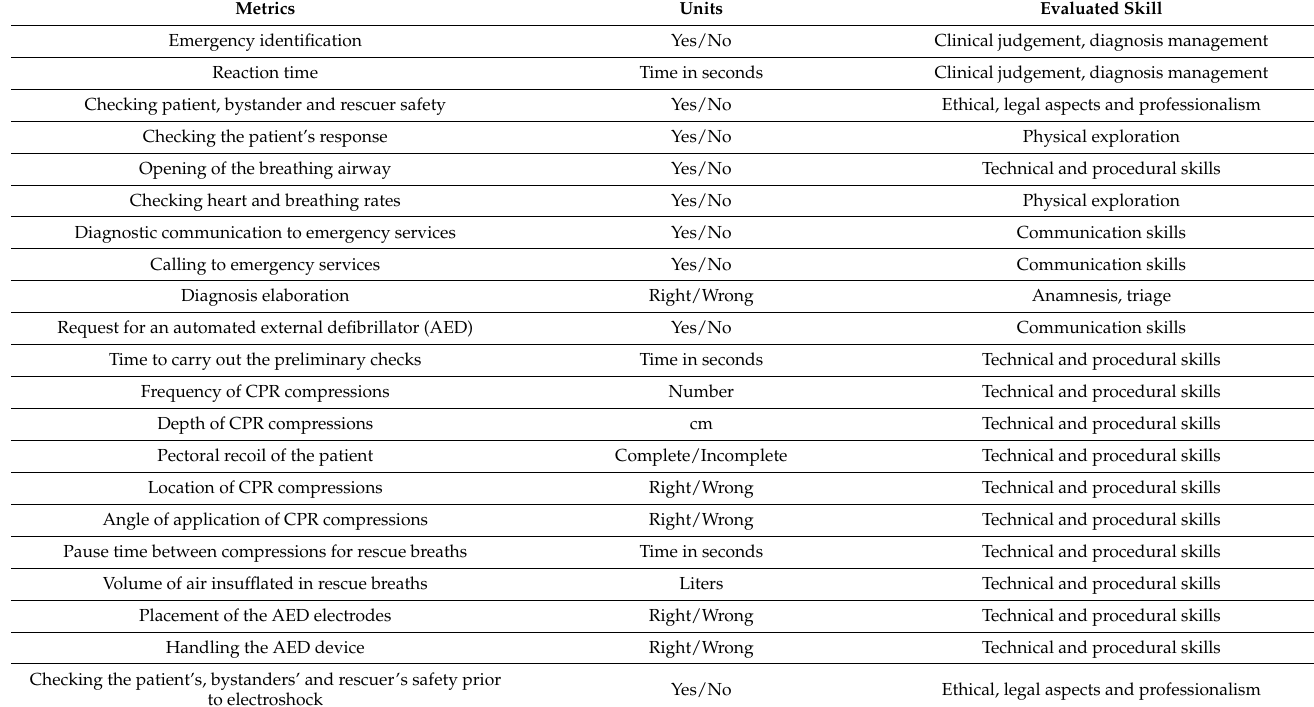
Table 1. Metrics obtained in the different systems and the evaluated skill based on the metric obtainment. Metrics